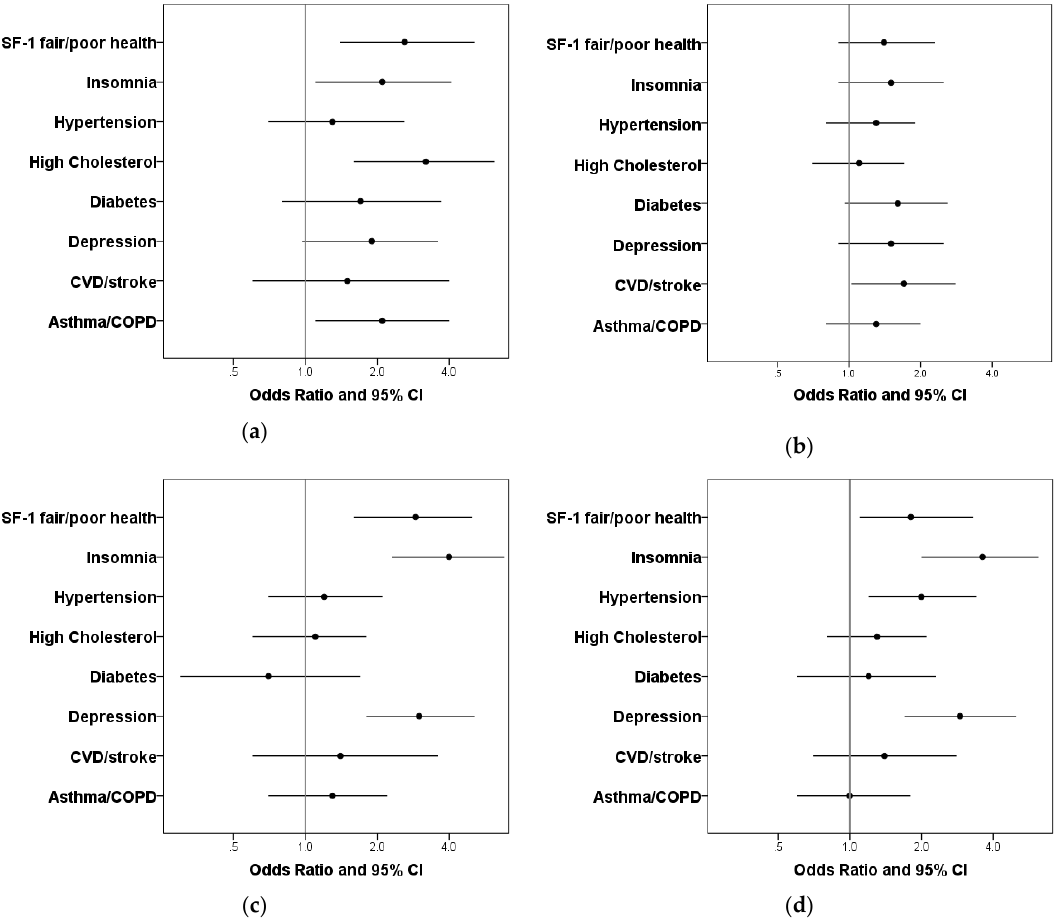
Figure 1. Adjusted odds ratio (OR) and 95% confidence intervals (CI) for comorbid conditions associated with diagnosed OSA and OSA symptoms not diagnosed ( a ) Women-diagnosed OSA; ( b ) Men-diagnosed OSA; ( c ) Women-OSA symptoms; ( d ) Men-OSA symptoms; 1 adjusted for age and body mass index (BMI); models for lung disease, cardiovascular disease, hypertension were adjusted for age, BMI, and smoking. Depression: Center for Epidemiologic Studies Depression Scale score ≥ 16; SF-1: Question one of the SF-36: In general, would you say your health is? (Excellent; very good; good; fair; poor). CVD = cardiovascular disease; COPD = chronic obstructive pulmonary disease.